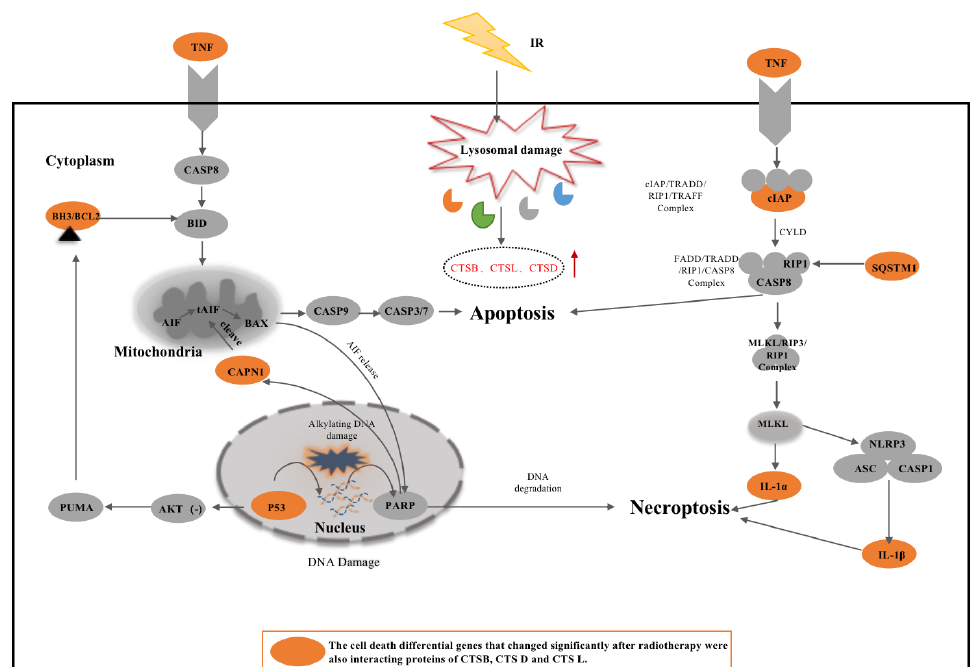
Figure 5. Differentially expressed CTSB, CTSL, and CTSD-interacting proteins after RT are involved in cell death. The orange circles represent the differentially expressed CTSB, CTSL, and CTSD-interacting proteins after RT.